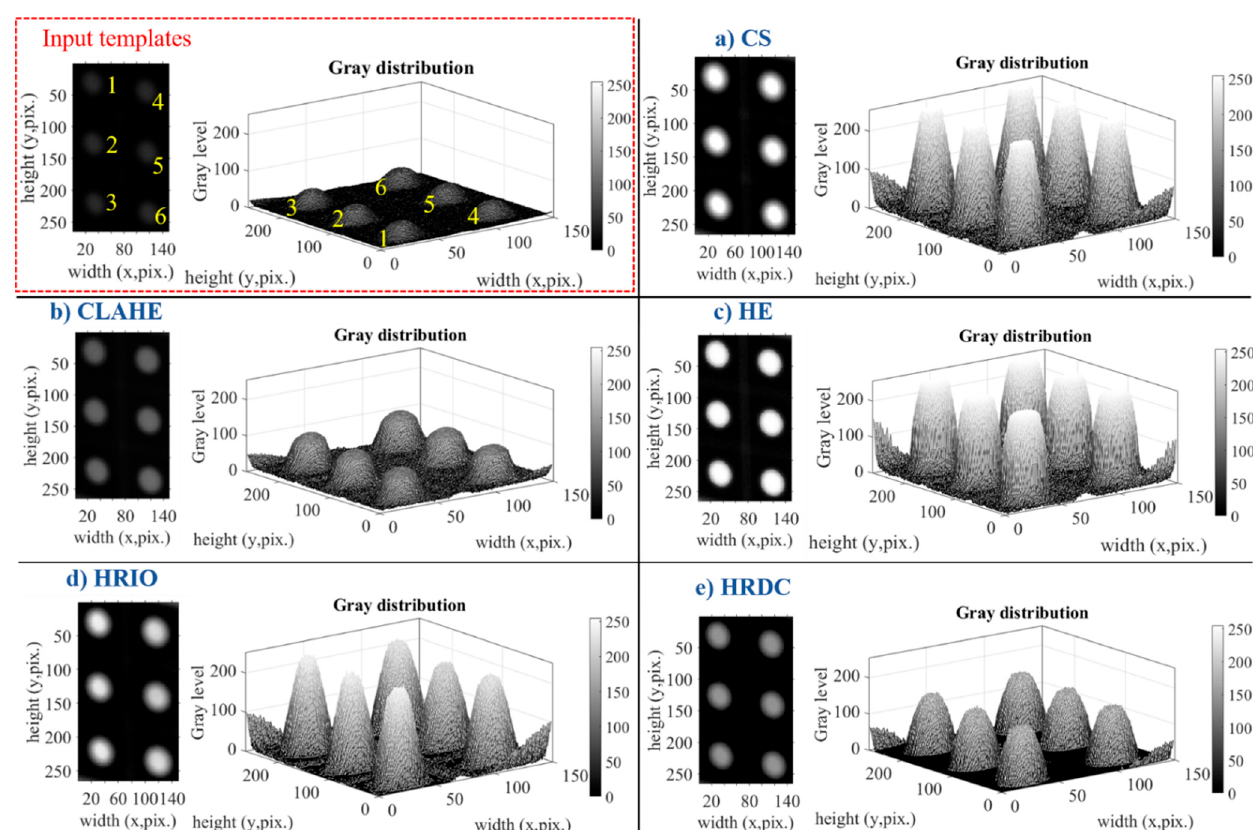
Figure 5. Gray level distribution of measured templates before ( top ‐ left ) and after enhancement procedures ( a – e ).